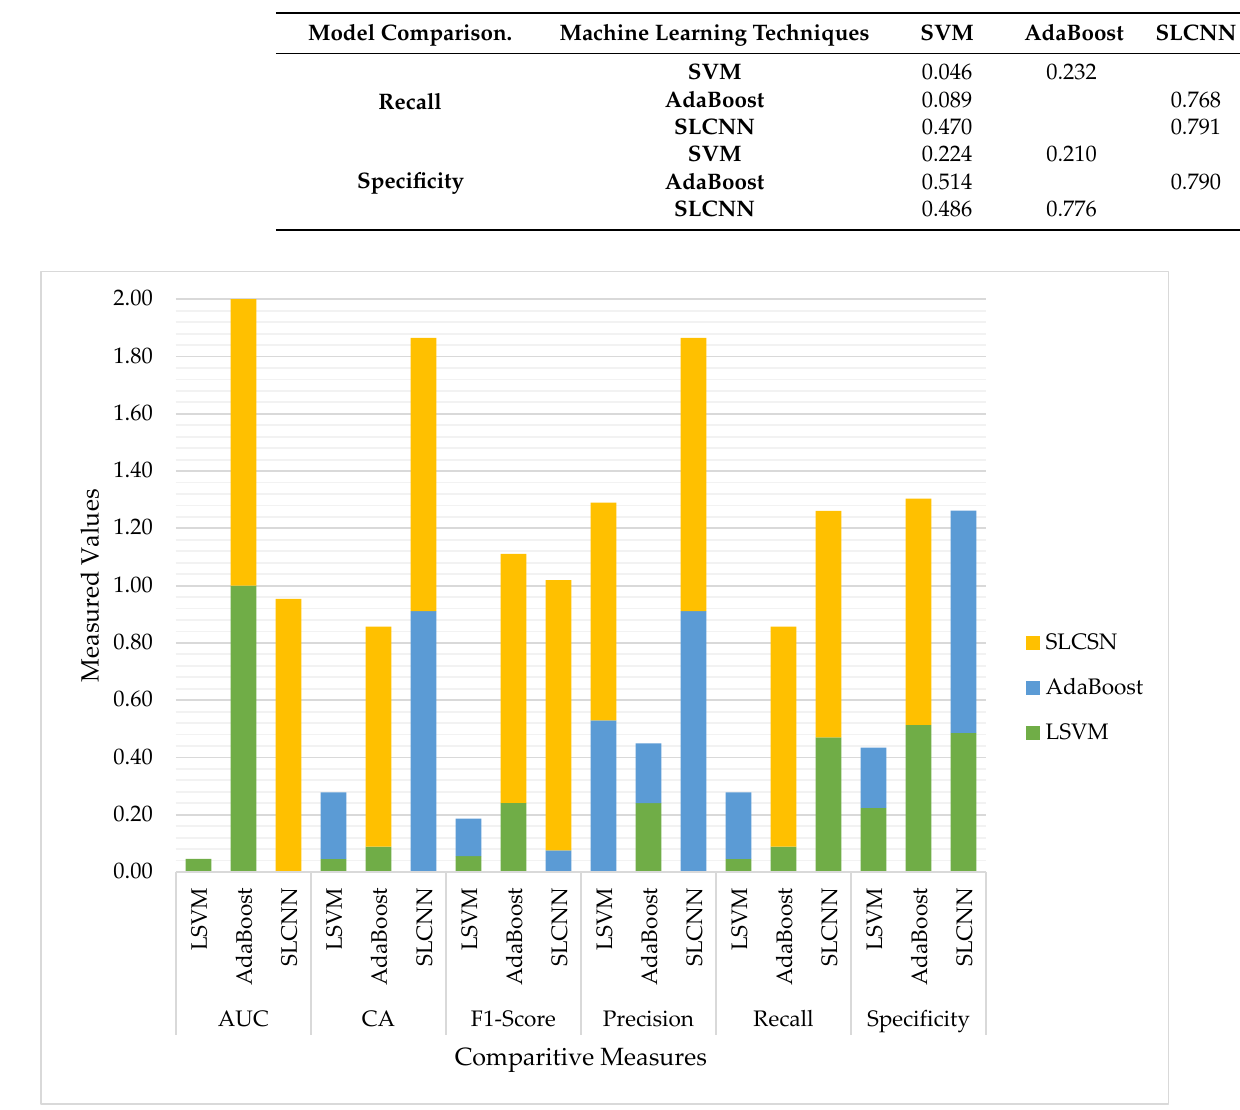
Figure 12. Models ’ Comparison for Identified Classifiers. Figure 12. Models’ Comparison for Identified